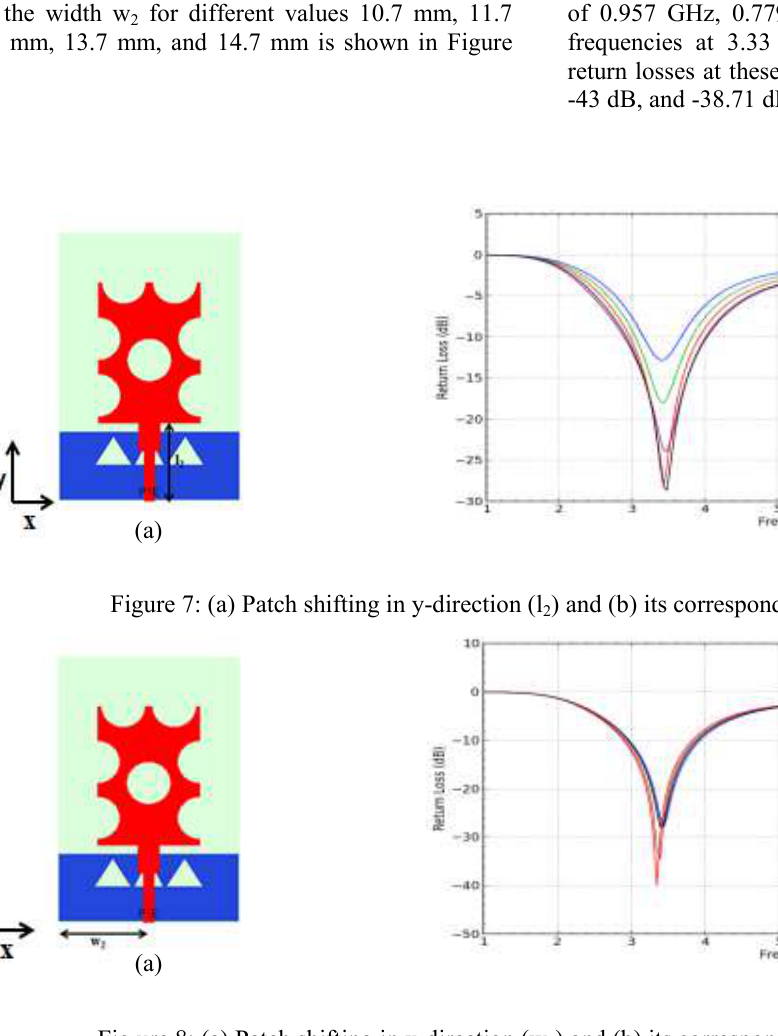
Fig.ure 8: (a) Patch shifting in x-direction (w 2 ) and (b) its corresponding optimization